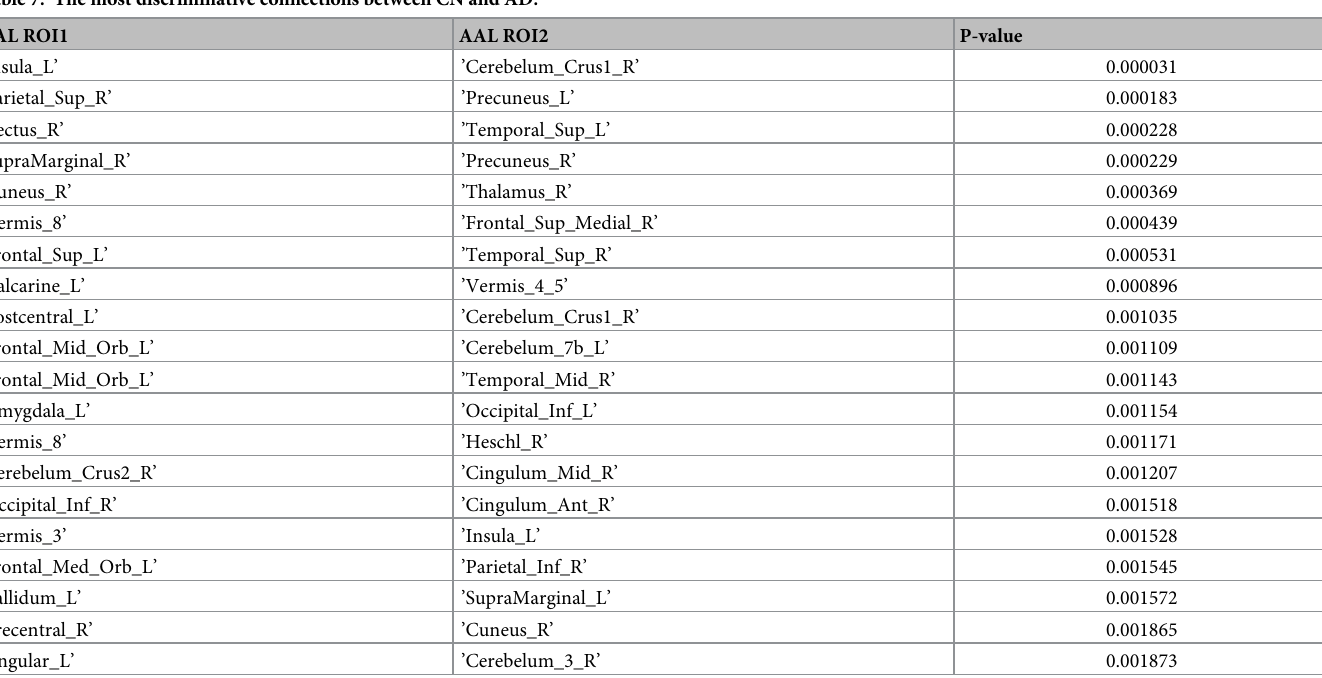
Table 7. The most discriminative connections between CN and